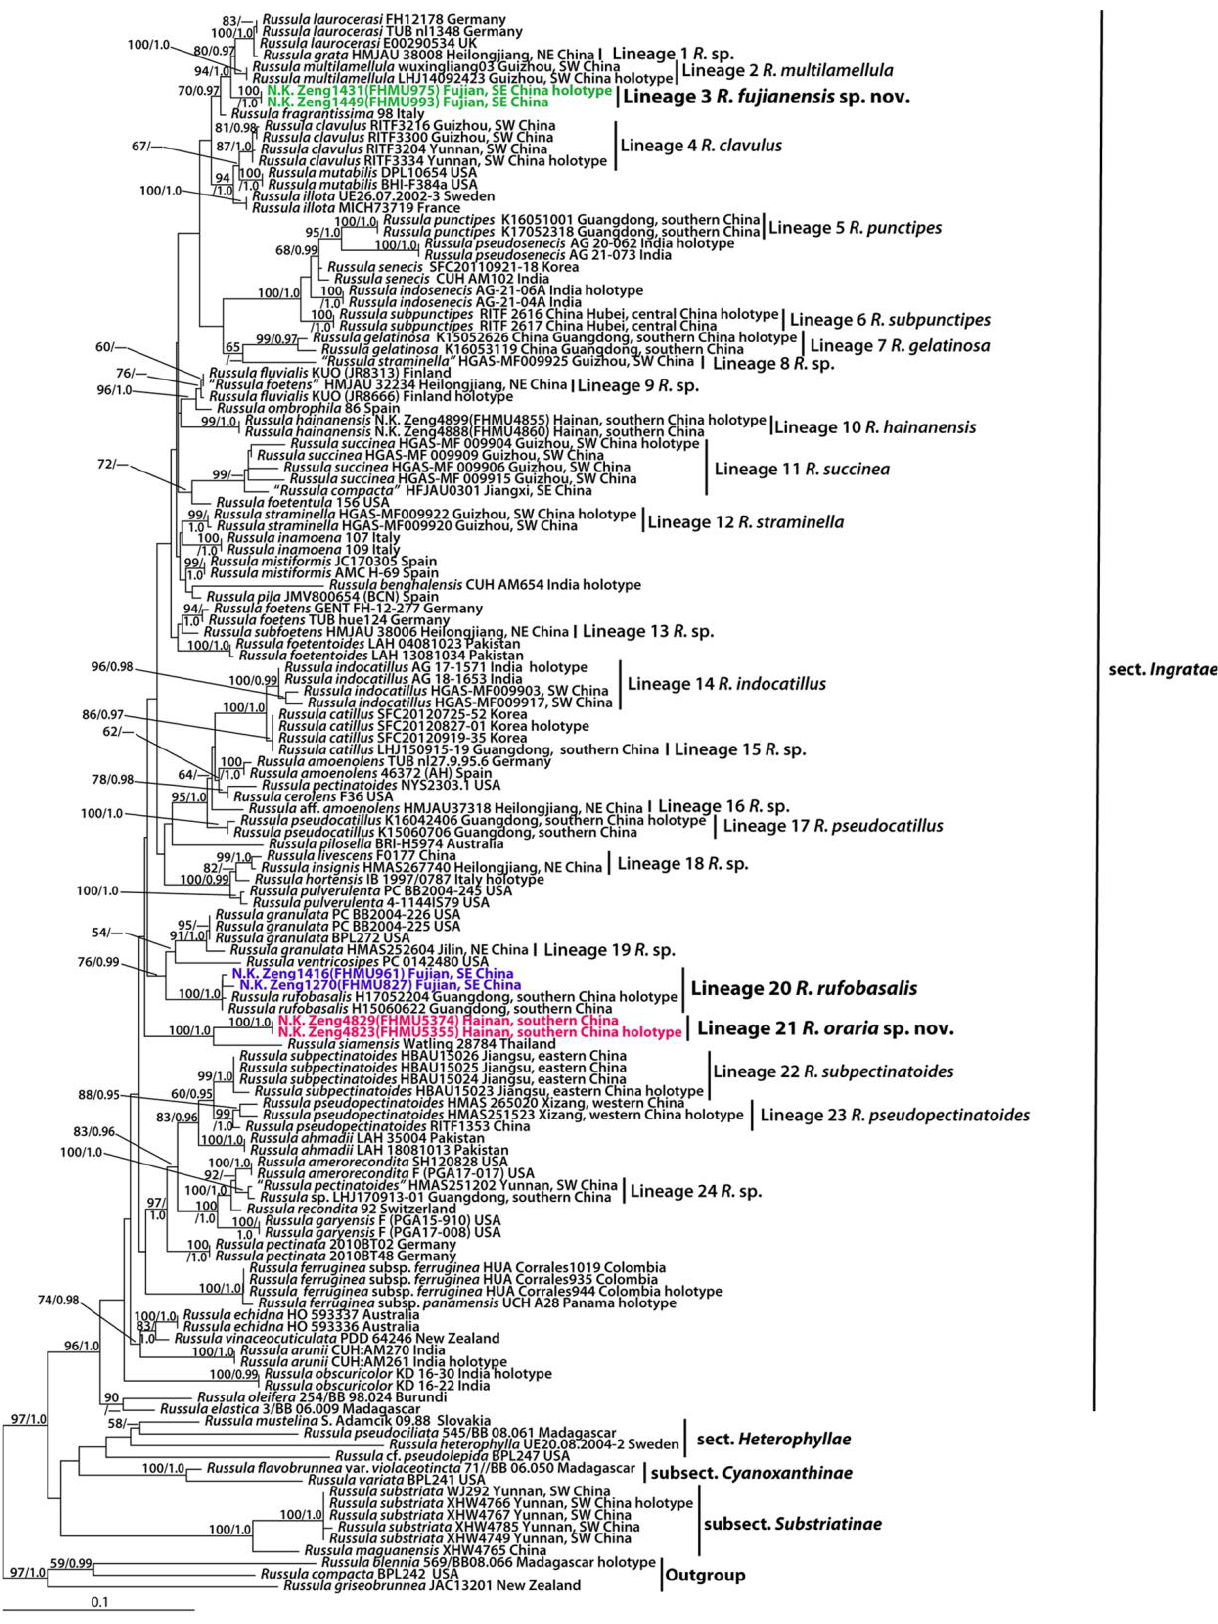
Figure 1. A phylogram of Russula sect. Ingratae inferred from a two-locus (rDNA 28S and ITS) dataset using RAxML. BS ≥ 50% and PP ≥ 0.95 are indicated above or below the branches as RAxML BS/PP. SW = Southwestern, SE = Southeastern, NE = Northeastern. Newly generated sequences are in color.